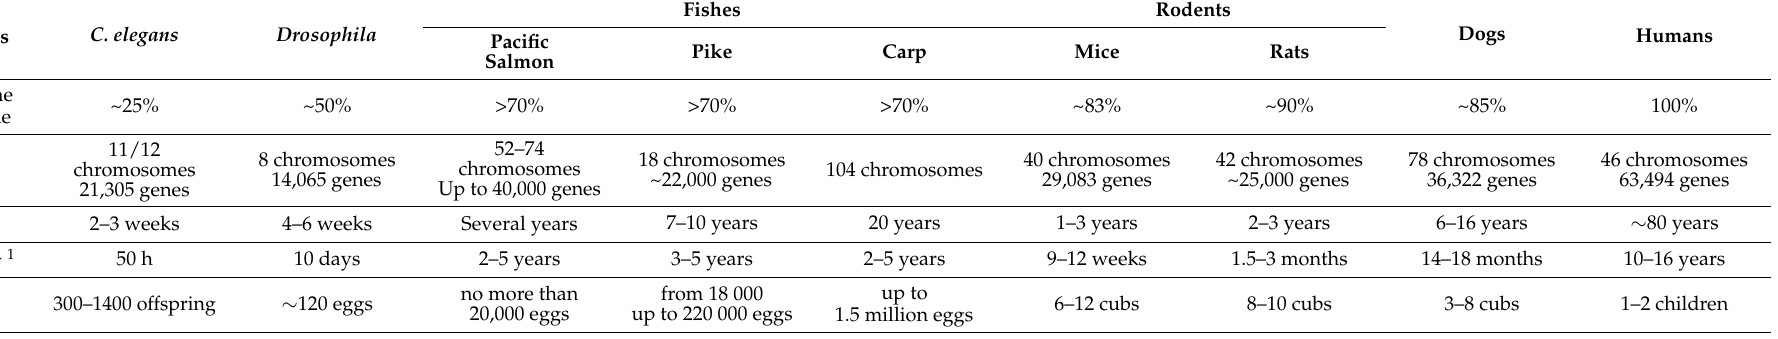
Table 1. The characteristics of various model organisms for studying aging. Adapted from Allard J.B. et al. [89], Taormina G. et al. [83], and Strange K.